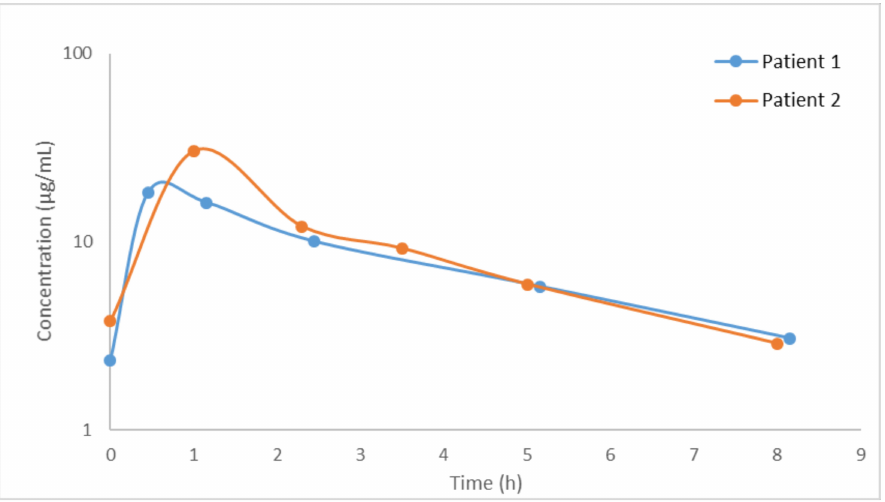
Figure 3. Plasma concentration of ceftaroline in the two critically ill patients.